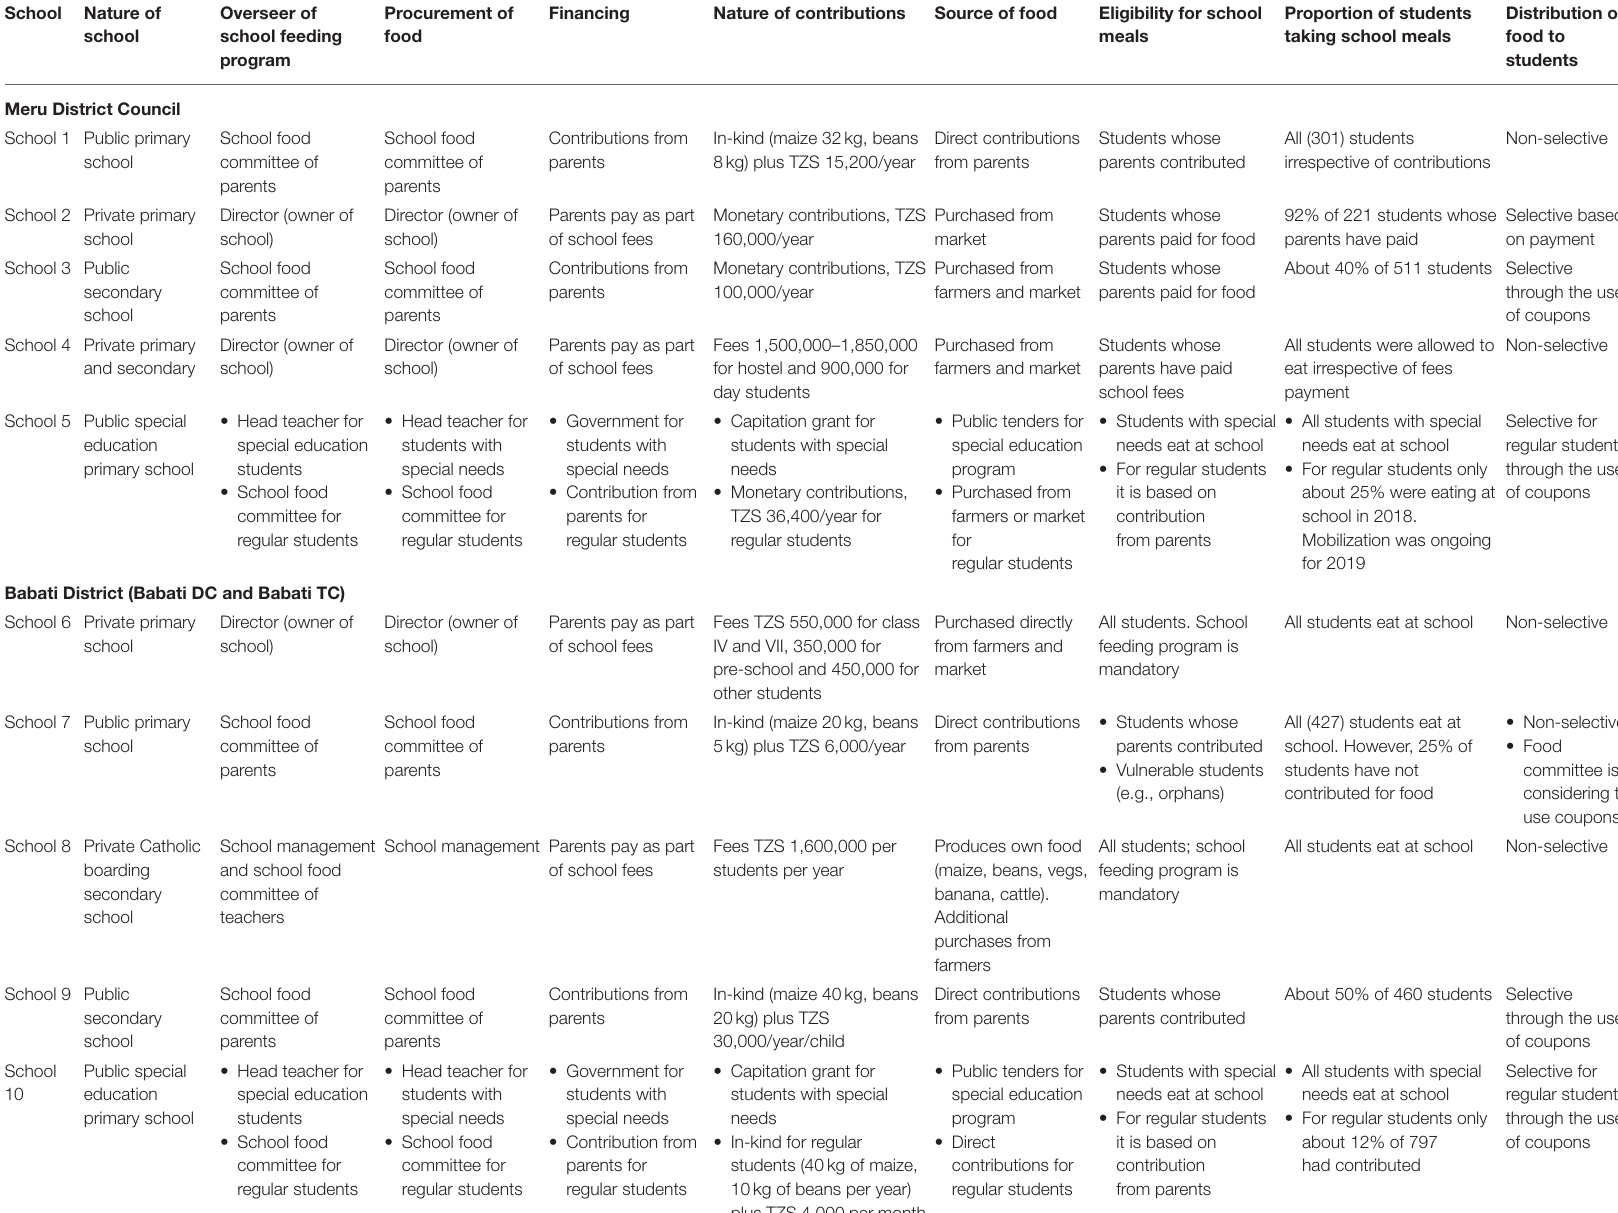
TABLE 3 | Procurement modalities of food for school feeding